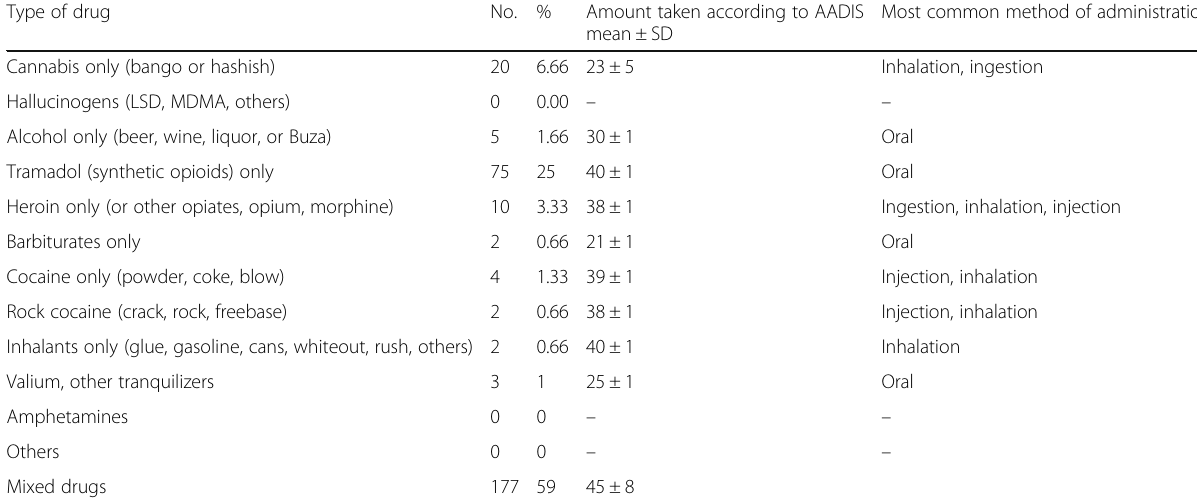
Table 3 Type, amount, and most common method of administration of the addictive drug used according to the AADIS (Adolescent Alcohol and Drug Involvement Scale) scale